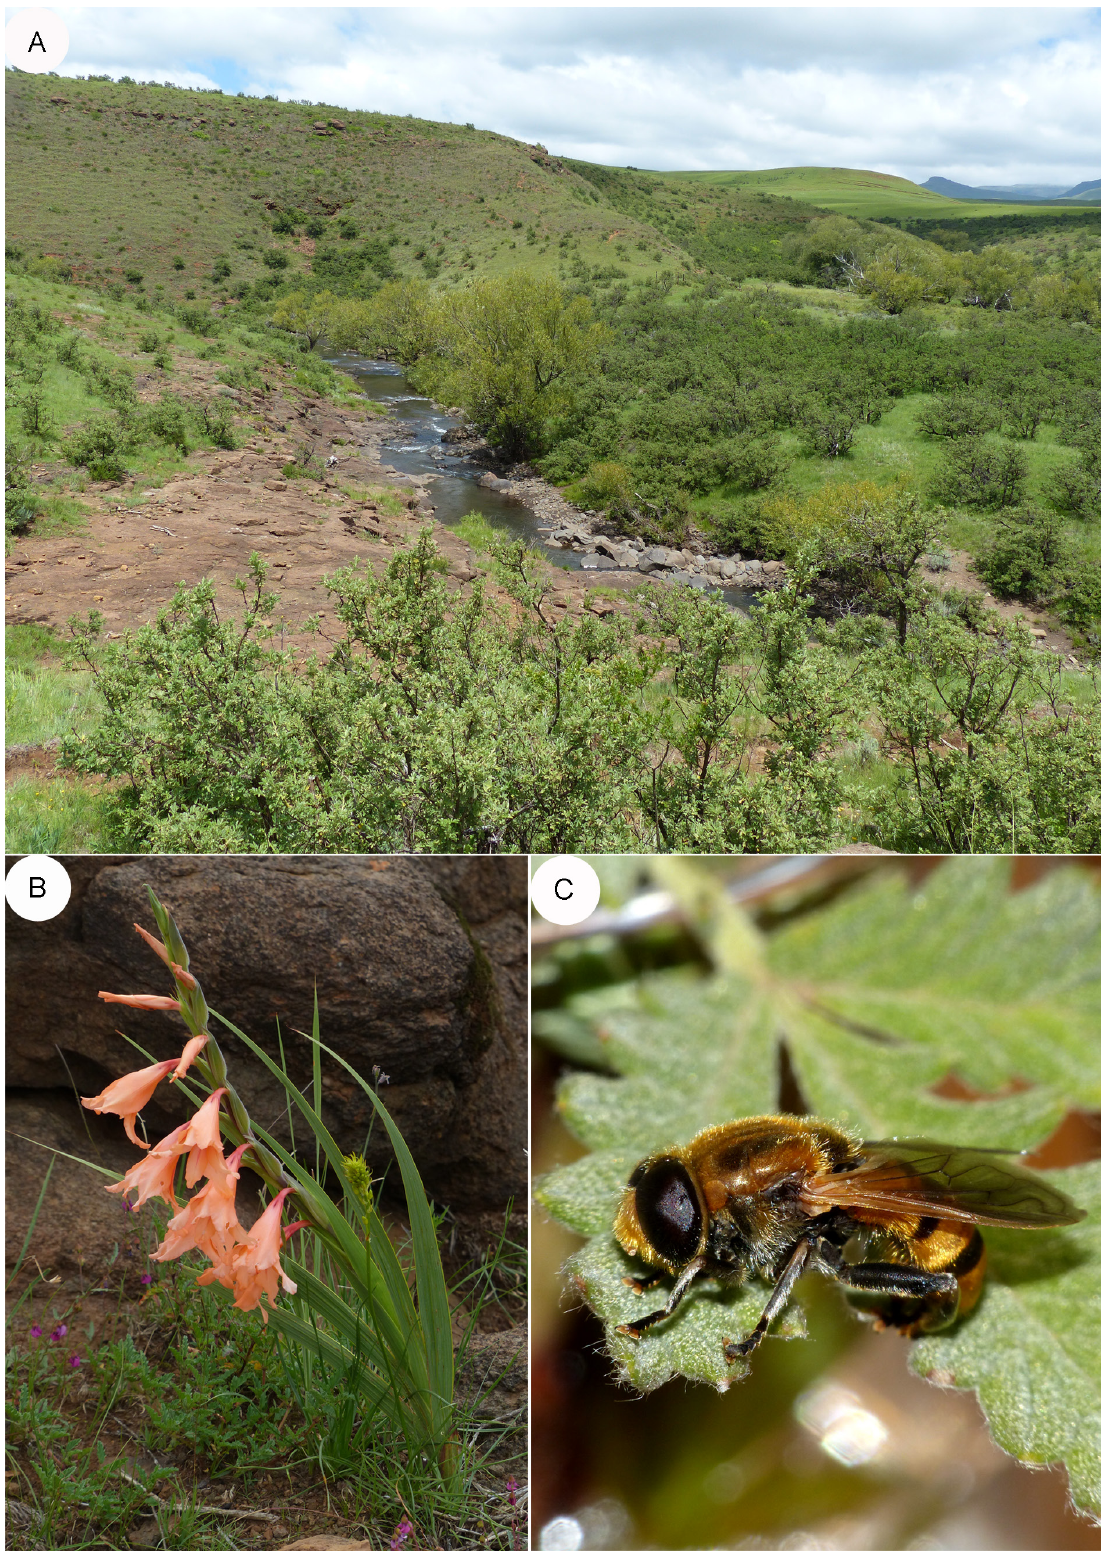
Fig. 24. Habitat of Merodon bombiformis Hull, 1944. A . Drakensberg Mountains, Maclear-Naudes Nek. B . Likely host plant Gladiolus sp. C . Merodon bombiformis male habitus. Photos by Axel